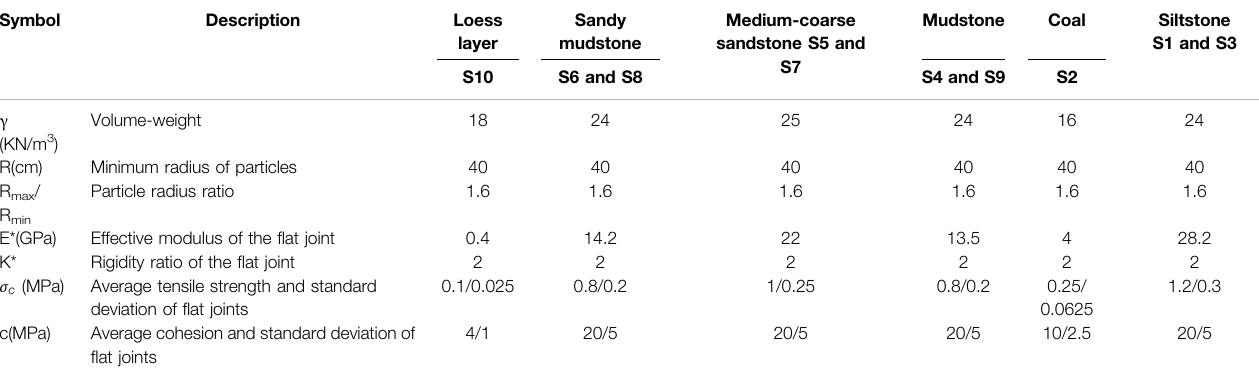
TABLE 4 | Mesoscopic parameters of